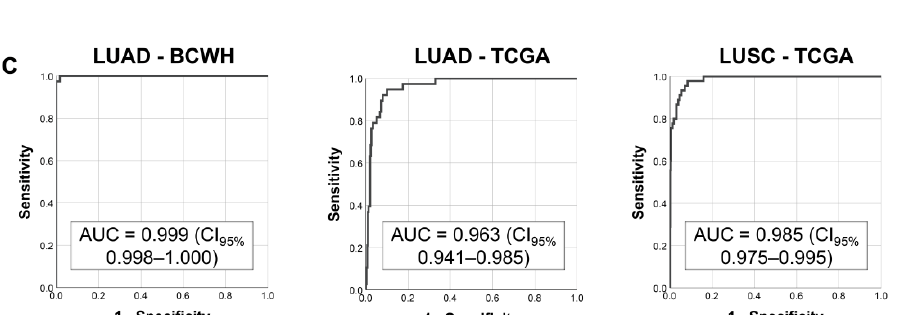
Figure 3. Training and testing of a lung oncofetal miRNA-based SVM. ( A ) Results of the training of the SVM on the BCWH cohort. Dotted line indicates the cut-off value of the SVM score. The formula for the SVM score was: Score = (1.24 × miR-301b) + (0.86 × miR-323b) + ( − 0.47 × miR-329) + ( − 0.24 × miR-380) + ( − 0.42 × miR-433) + ( − 0.26 × miR-543) + (0.01 × miR-627) + (1.12 × miR-6516) + (0.44 × miR-1290) + (0.34 × miR-1343) + (1.01 × miR-3170) + (0.97 × miR-4787) + (0.02 × miR-5684), with all expression values in units of log 2 (RPM). AUC = area under the receiver operating characteristic curve; ( B ) Distributions of the SVM scores for the non-malignant and malignant samples within the TCGA Pan-Cancer cohort. Error bars indicate the mean score ± standard deviation. LUSC: lung squamous cell carcinoma, UCEC: uterine corpus endometrial carcinoma, BLCA: bladder urothelial carcinoma, HNSC: head and neck squamous cell carcinoma, BRCA: breast invasive carcinoma, ESCA: esophageal carcinoma, KIRP: kidney renal papillary cell carcinoma, STAD: stomach adenocarcinoma, KIRC: kidney renal clear cell carcinoma, PRAD: prostate adenocarcinoma, LIHC: liver hepatocellular carcinoma, THCA: thyroid carcinoma, KICH: kidney chromophobe; ( C ) Receiver operating characteristic curves illustrating the performance of the SVM on the training (LUAD-BCWH) cohort, as well as on the LUAD-TCGA and LUSC-TCGA cohorts. CI 95% : 95% confidence